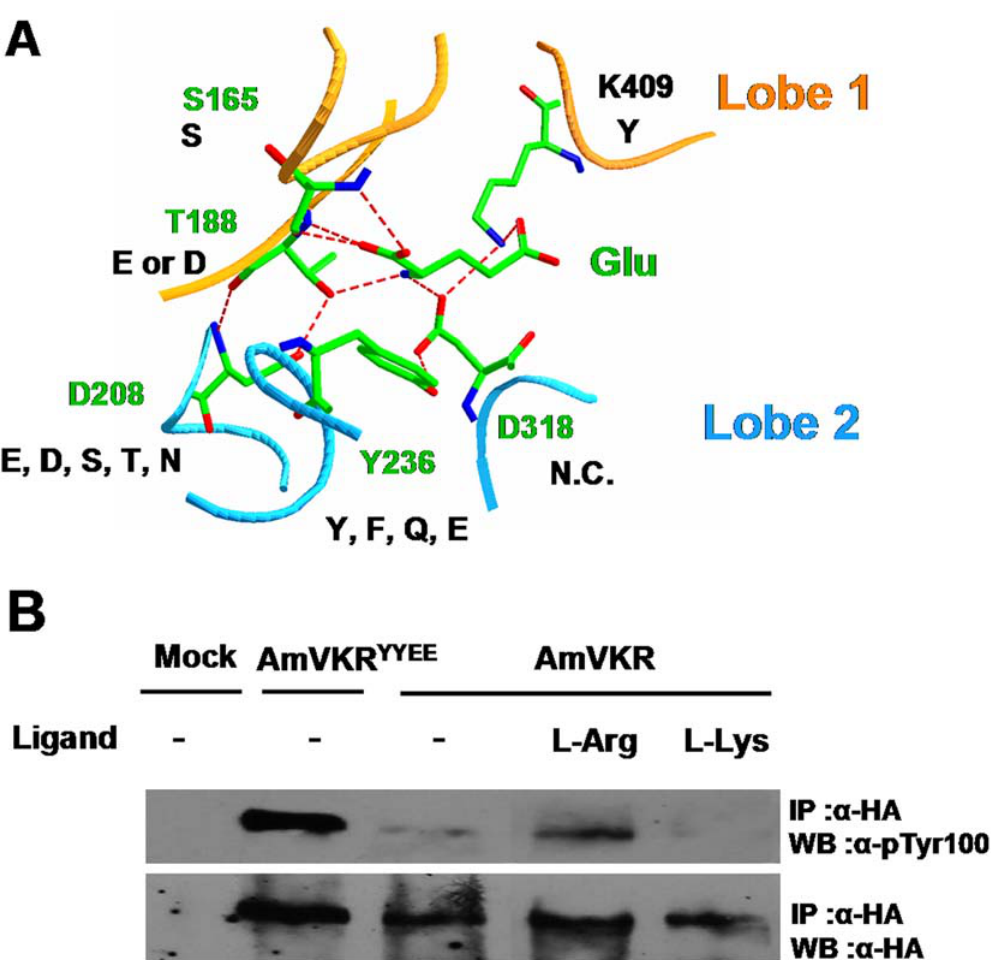
Figure 9. VKR VFTM can bind L-aminoacids responsible for activation. A- Detailed view of glutamate binding in the VFTM of mGlu1 structure. The five residues (labeled in green) responsible for the binding of the a -amino acid functions of the glutamate, and the equivalent residues in VKRs (in black) are shown. The conserved Lys409 in mGlu1 that interact with the carboxylate function of the glutamate side-chain is displayed, and the corresponding tyrosine residue in VKR is indicated. B- Modulation of recombinant AmVKR protein tyrosine kinase activity by aminoacid ligands. Kinase assays were performed on HA-tagged AmVKR immunoprecipitated from transfected HEK293 cells as described in Fig. 7C. L-Arg or L-Lys (100 m M final concentration) amino-acids were added to AmVKR kinase assay reactions, and the constitutively active AmVKR YYEE proteins were used as positive control.